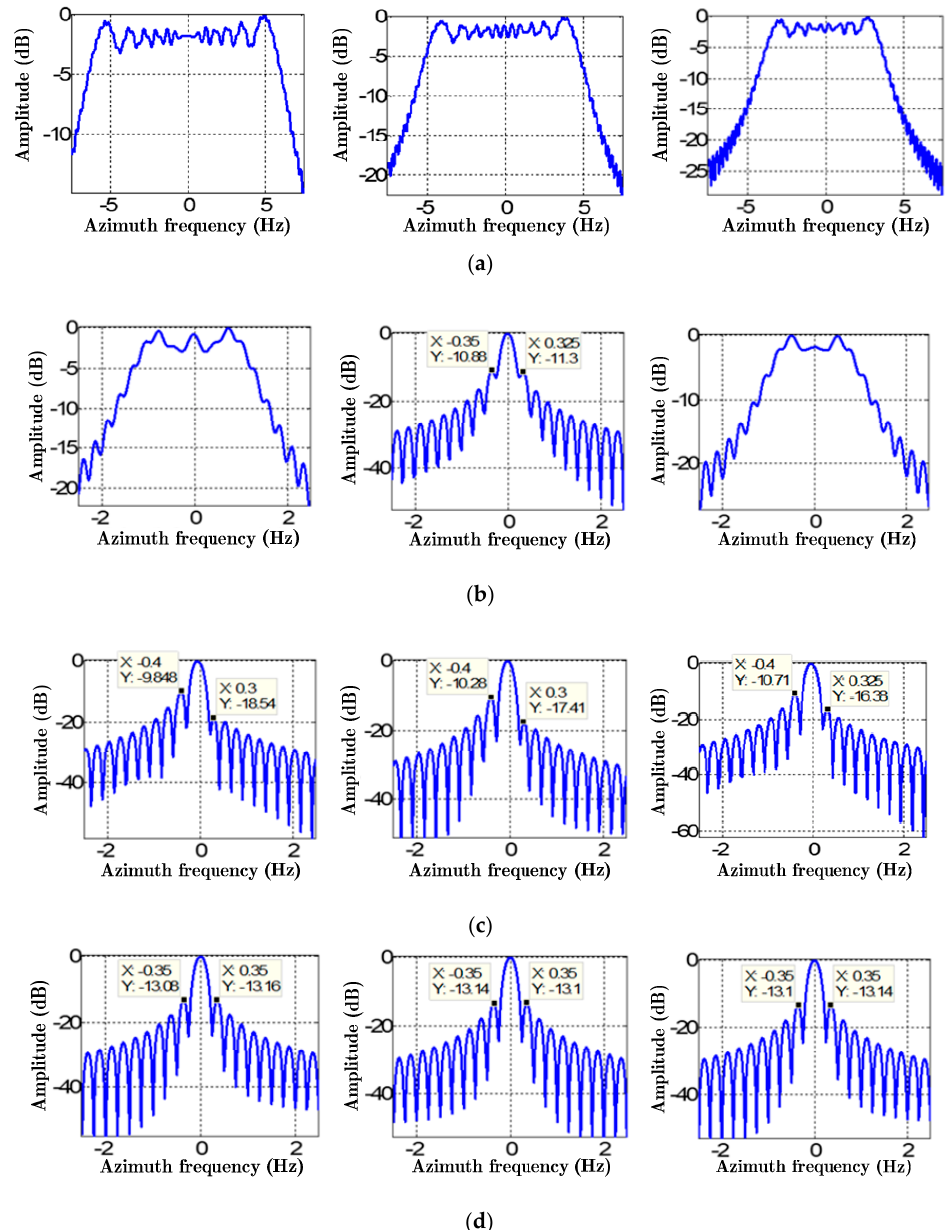
Figure 10. The azimuth impulse responses of targets by the different methods with the velocity and acceleration errors. ( a ) No Doppler parameter estimation; ( b ) the basic MAM method; ( c ) the IMAM method; ( d ) the EMAM method.